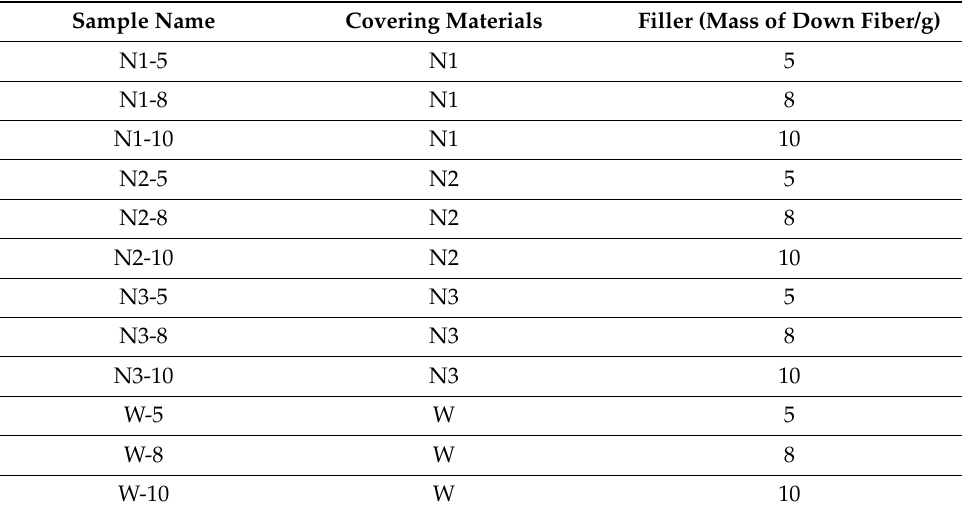
Figure 1. Flowchart of composite waddings. Table 3. Parameters of composite waddings.